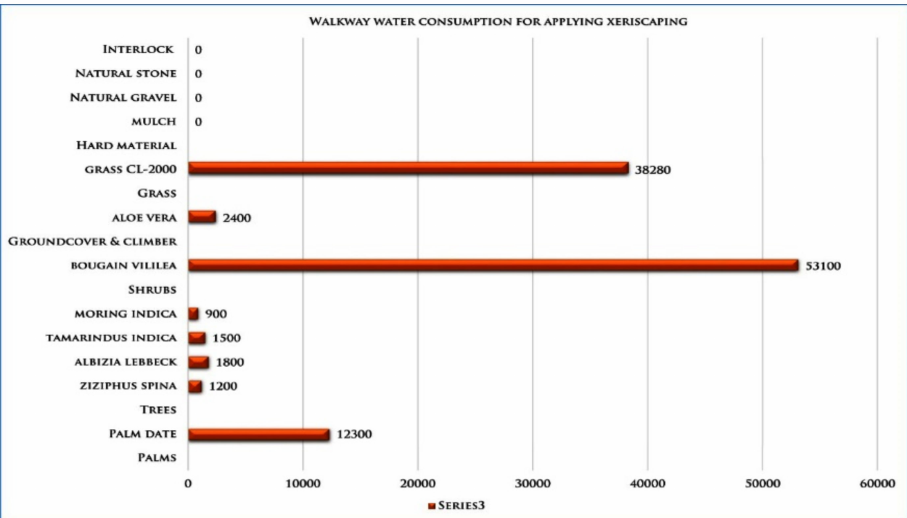
Figure 20. Experiment 4, water consumption quantity after applying xeriscaping items. Xieriscaping softscape design water consumption (Details in Table